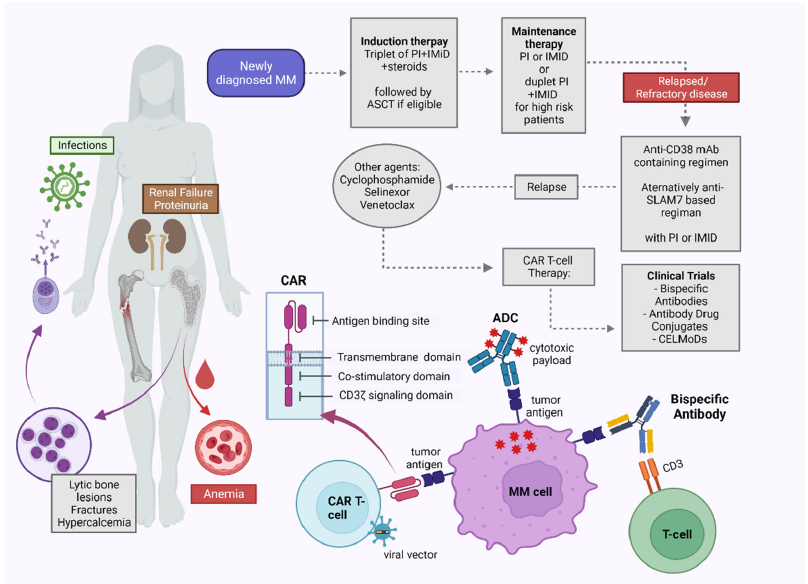
Figure 3. The basic principles of the immunotherapies in MM and their place in the current treatment landscape. CAR T cells are T cells genetically modified with the use of a viral vector to express a chimeric antigen receptor on their surface, which targets specific tumor antigens of malignant plasma cells. Similarly, bispecific antibodies are monoclonal antibodies targeting both an antigen on the malignant MM cells and simultaneously an antigen on the surface of physiologic T cells, creating an immunologic bridge. ADC are monoclonal antibodies against antigenic epitopes on the surface on MM cells, carrying a cytotoxic payload. The binding of the above agents to their antigenic targets on malignant MM cells leads to activation of the immune system, with subsequent destruction of the MM cells. 5.4.1. B Cell Maturation Antigen (BCMA) The most well-studied ADC target to date is BCMA, which is a member of the tumor necrosis factor receptor family exclusively expressed on plasma cells and late mature B cells [144]. Activation of BCMA by its ligands, B cell activating factor (BAFF) and a prolif- eration-inducing ligand (APRIL), is required for the survival of PCs [145,146]. At present, there are several different ADCs under development that target the BCMA carrying dif- ferent types of linkers and payloads. The anti-BCMA ADC belantamab mafodotin (GSK2857916) is a humanized IgG1 anti-BCMA mAb carrying a non-cleavable linker to the tubulin polymerization inhibitor monomethyl aurastatin-F (mcMMAF) [143]. Apart from the classic mechanism of cell death after the endoplasmic release of mcMMAF, belantamab mafodotin can also induce cell lysis via effector-cell-mediated ADCC, with the defucosylated Fc region of the mAb helping to facilitate this interaction [143,147]. Malignant cell lysis releases tumor antigens, locally triggering a robust immune response against myeloma cells. [146,147]. The clinical safety and efficacy of belantamab mafodotin monotherapy in heavily pretreated MM pa- tients were confirmed in the DREAMM-1 and DREAMM-2 clinical trials [148–150]. At present, belantamab mafodotin is being studied in combination with other anti-myeloma agents in phase 2 and 3 clinical trials (NCT03715478, NCT03544281, NCT04246047 and NCT04484623). To date, it is the only ADC approved by the FDA, as a single agent, for the treatment of MM patients who have received at least four prior therapies including an anti-CD38 mAb, a PI, and an IMiD [149,151,152]. Other anti-BCMA ADC include AMG224, MEDI2228, CC-99712, and HDP-101. AMG224 is a mAb conjugated with antitubulin maytainsinoid using a noncleavable